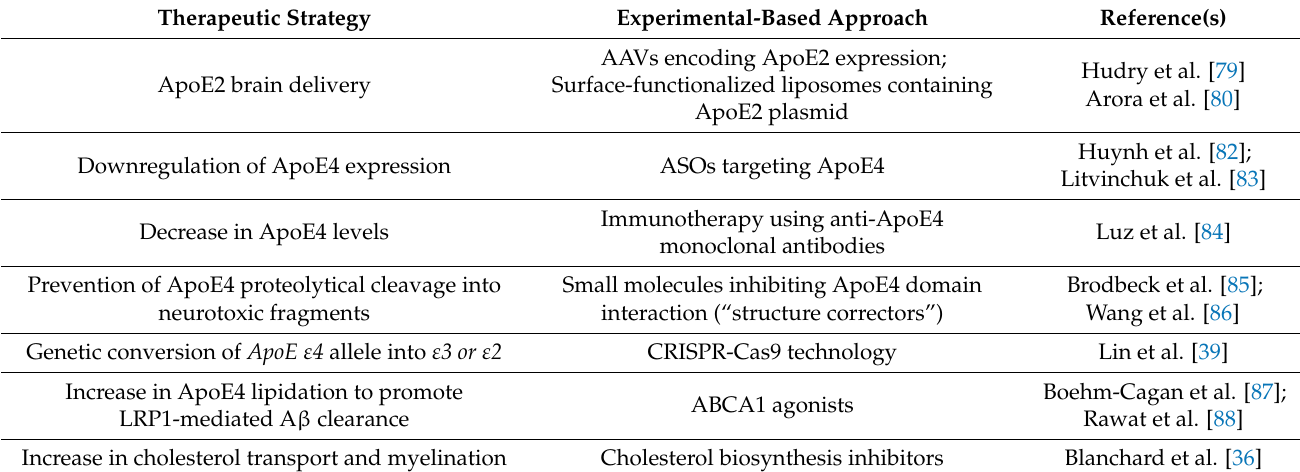
Table 1. Summary of ApoE-related therapeutic strategies and respective experimental-based approaches. Therapeutic Strategy Experimental-Based